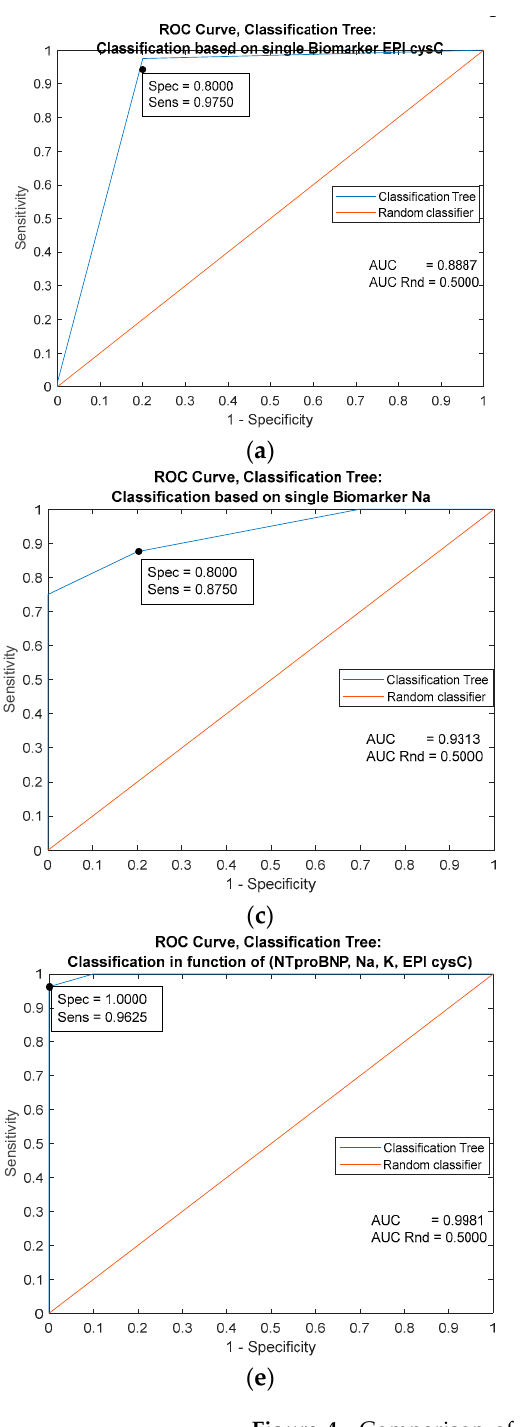
Figure 4. Comparison of the performance of decision tree classifiers based on four individual pre- dictors ( a – d ) and on the combination of all mentioned predictors ( e ).